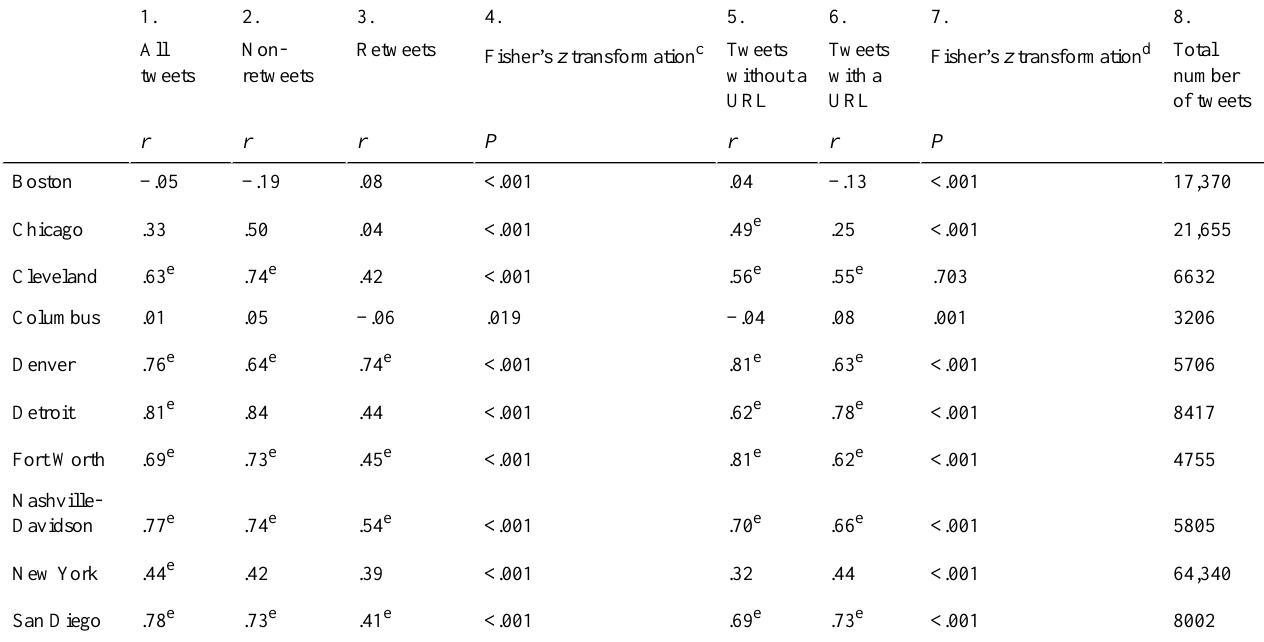
Table 2. Correlations between tweets and sentinel-provided ILI a rates. b